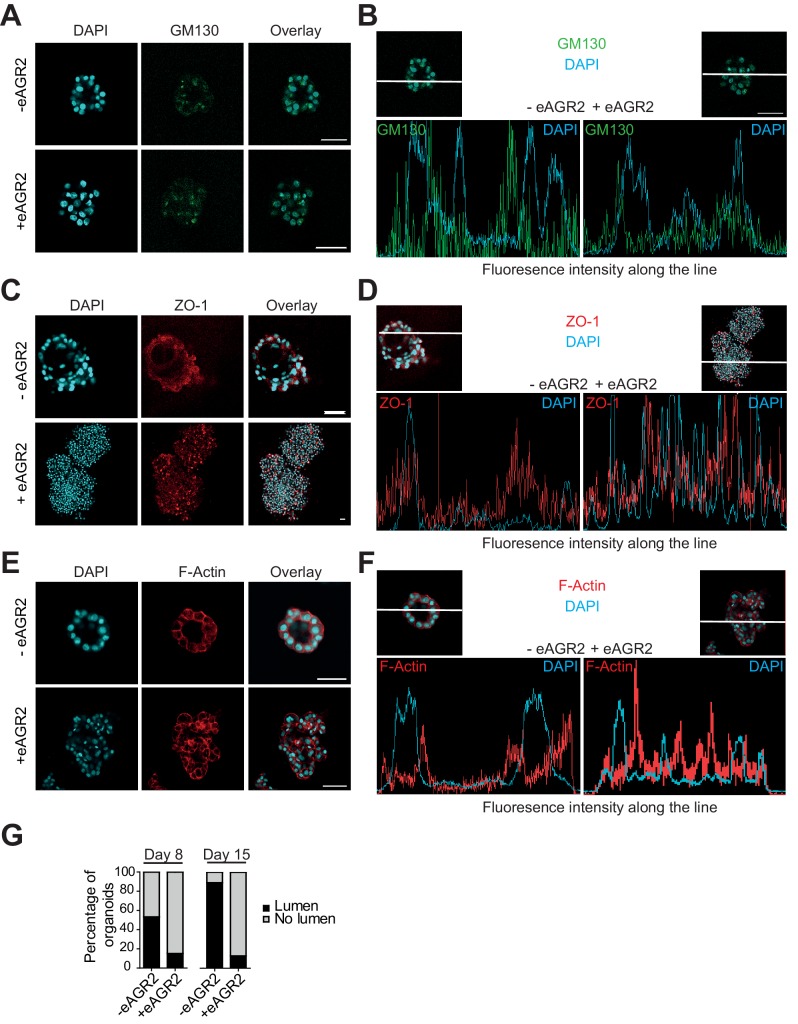
Extracellular AGR2 disrupts apico-basal polarity and lumen formation.(A, C, E) HBEC cultured organoids in the presence (+ eAGR2) or absence (-eAGR2) of AGR2 in the ECM, stained for GM130 (A), ZO-1 (B) and F-Actin (C). Scale bars, 50 μm. Note the repositioning or fragmentation of Golgi following the presence of eAGR2. (B, D, F) Fluorescence intensity profile along the white line across the organoid in the presence (+ eAGR2, right panel) or absence (-eAGR2, left panel) of AGR2 in the ECM, stained with DAPI and GM130 (B), ZO-1 (D) and F-Actin (F). (G) Quantification of organoids with lumens; n>100 for each condition, (n=3).